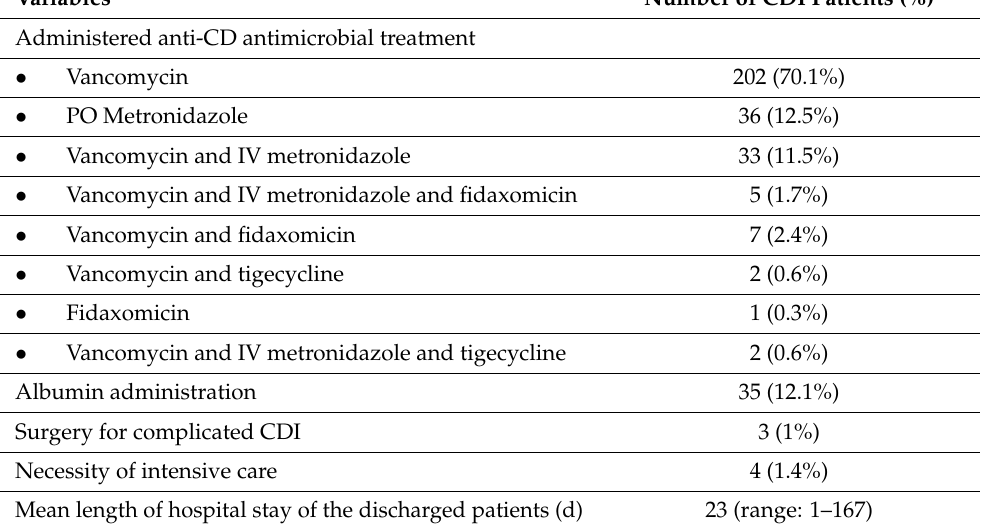
Table 2. Characteristics of the 288 patients with a first CDI at the end of anti-CDI treatment for their first CDI episode and resolution of diarrhea. SD: standard deviation. PO: per os. IV: intravenous